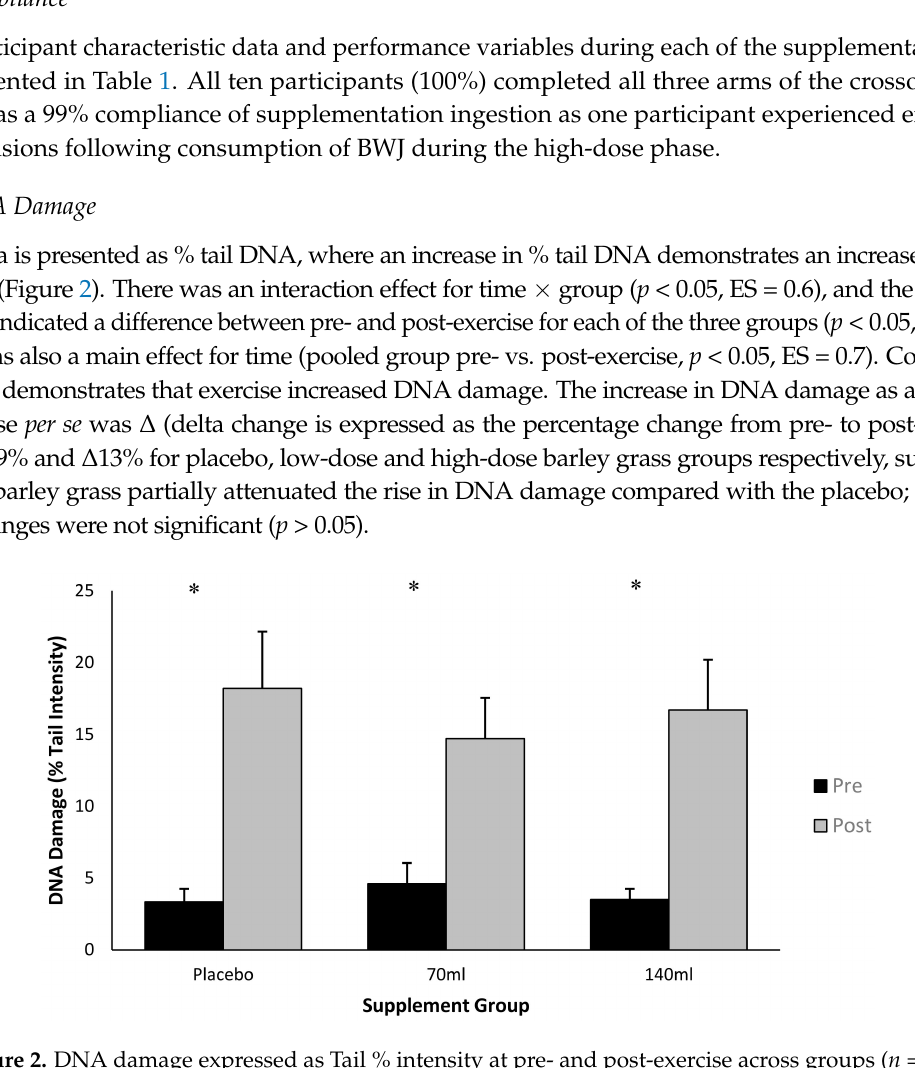
Figure 2. DNA damage expressed as Tail % intensity at pre- and post-exercise across groups ( n = 10). Data expressed as a mean ± standard deviation.* represents a significant interaction effect ( p < 0.05) within